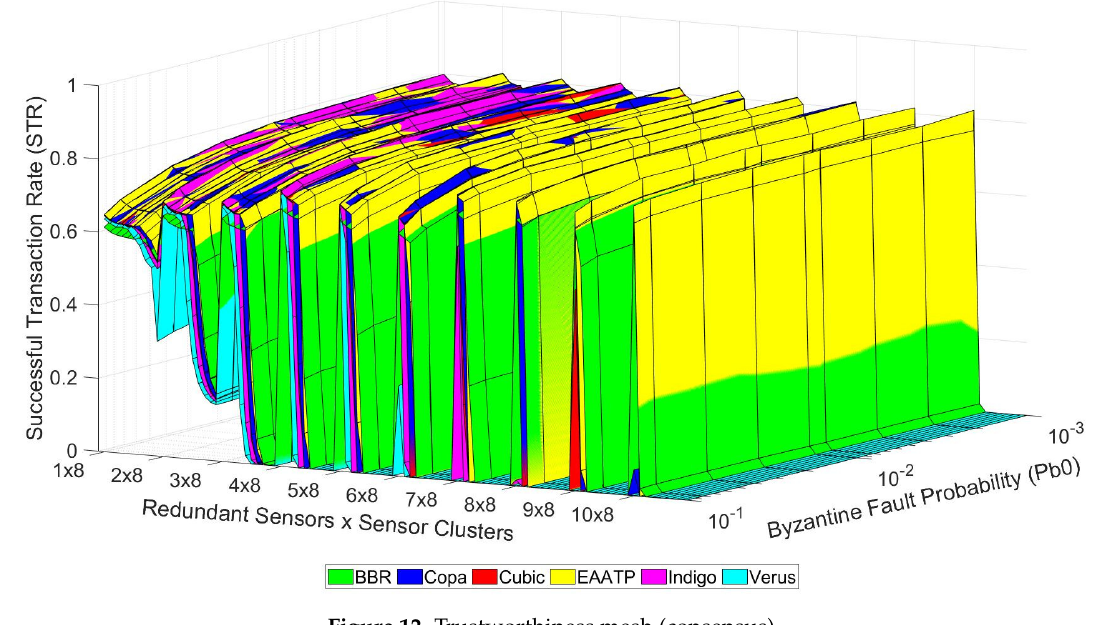
Figure 12. Trustworthiness mesh (consensus).